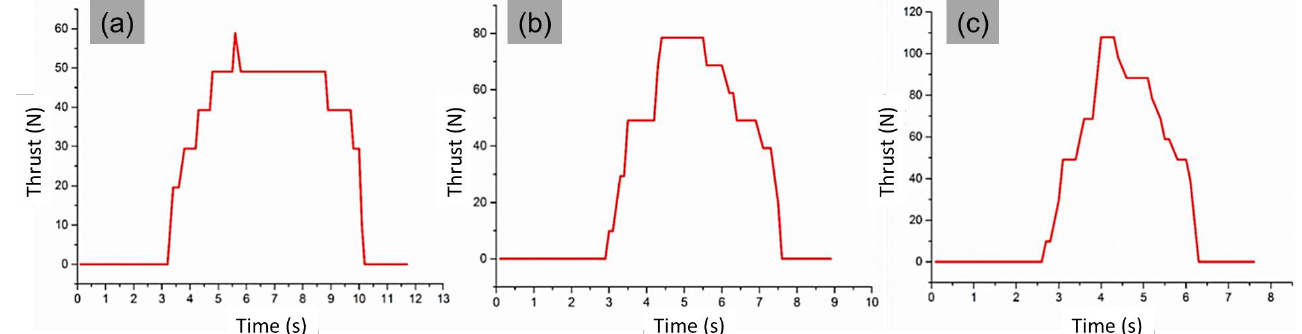
Figure 3. Drilling cycles for specimens machined with 90° point angle and spindle speed of 2000 rpm with a ( a ) feed rate 100 mm/min and thrust force 58.56 N, ( b ) feed rate 150 mm/min and thrust force 78.48 N, and ( c ) feed rate 200 mm/min and thrust force 107.91 N.